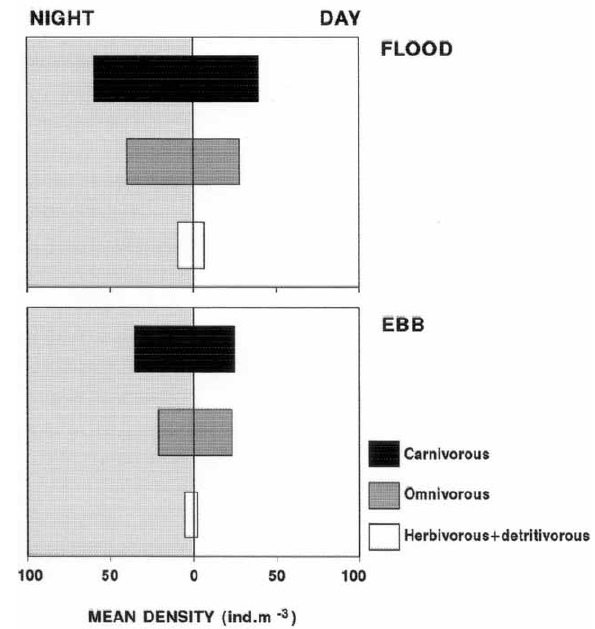
F IG . 6. – Mean density of zooplankton trophic levels, during flood and ebbs, in the day and night periods, at the three depths. Concentrations (ind. m -3 ) are represented by horizontal bars. Shaded area: night.